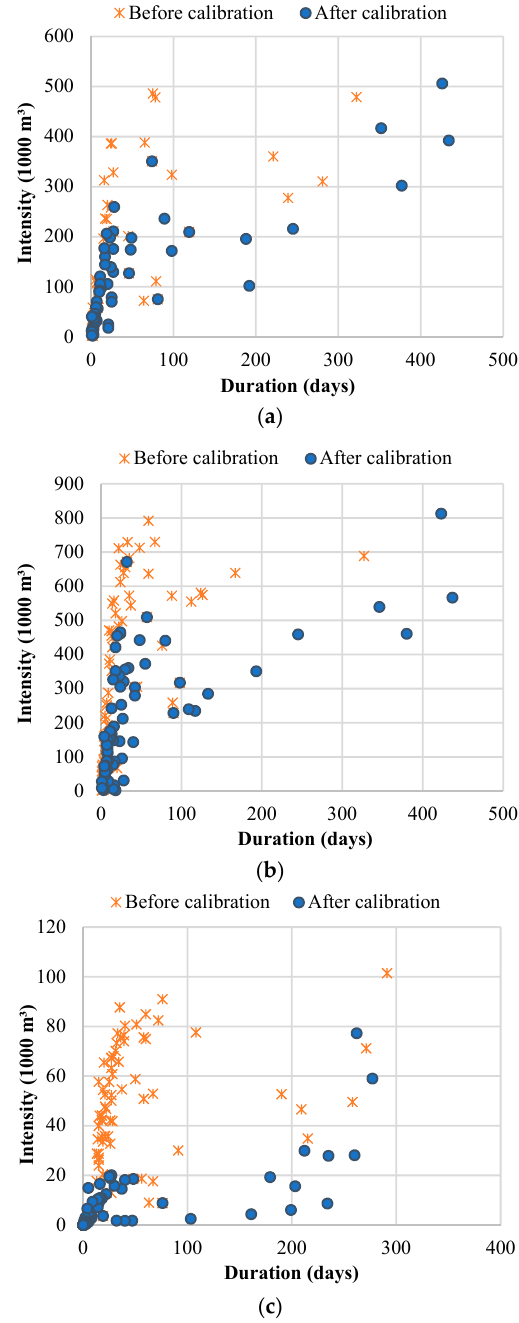
Figure 10. Intensity and duration of reservoir drought conditions of Kicheon, Deokwoo, and Samchun agricultural reservoirs. ( a ) Kicheon reservoir; ( b ) Deokwoo reservoir; ( c ) Samchun reservoir.